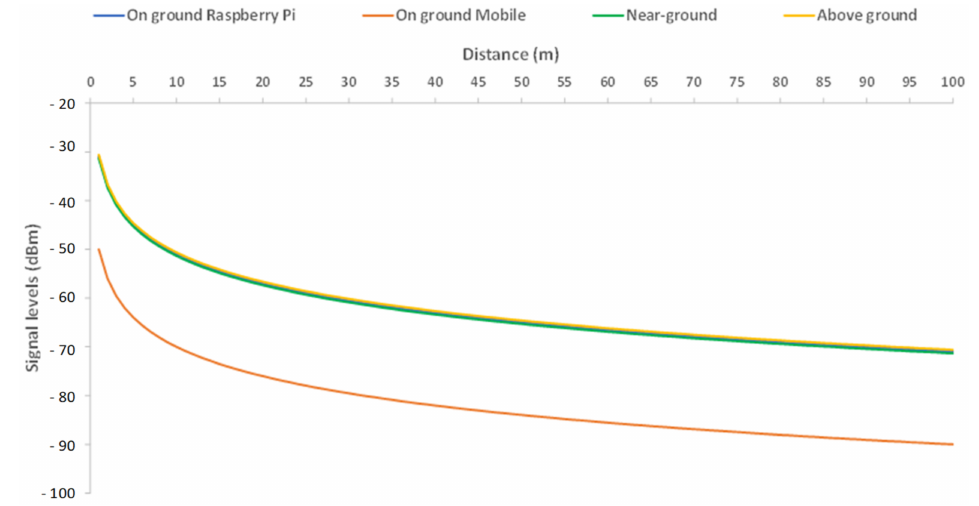
Figure 5. Signal levels under air–water interface conditions with distance between nodes of 1